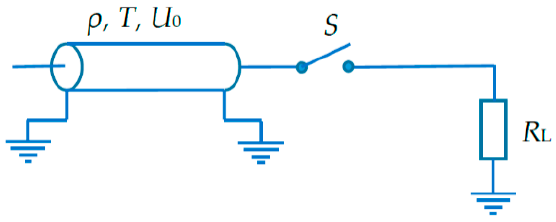
Figure 2. Equivalent discharge circuit of single coaxial PFL.